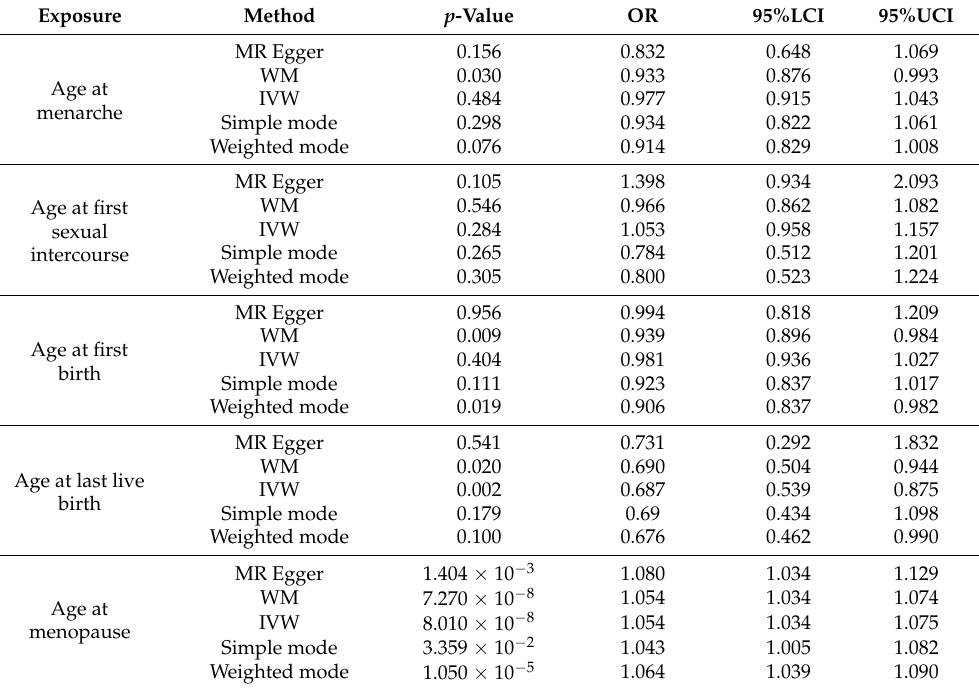
WM: weighted median; IVW: inverse-variance weighted; OR: odds ratio; LCI: lower confidence interval; UCI: upper confidence interval; BC: breast